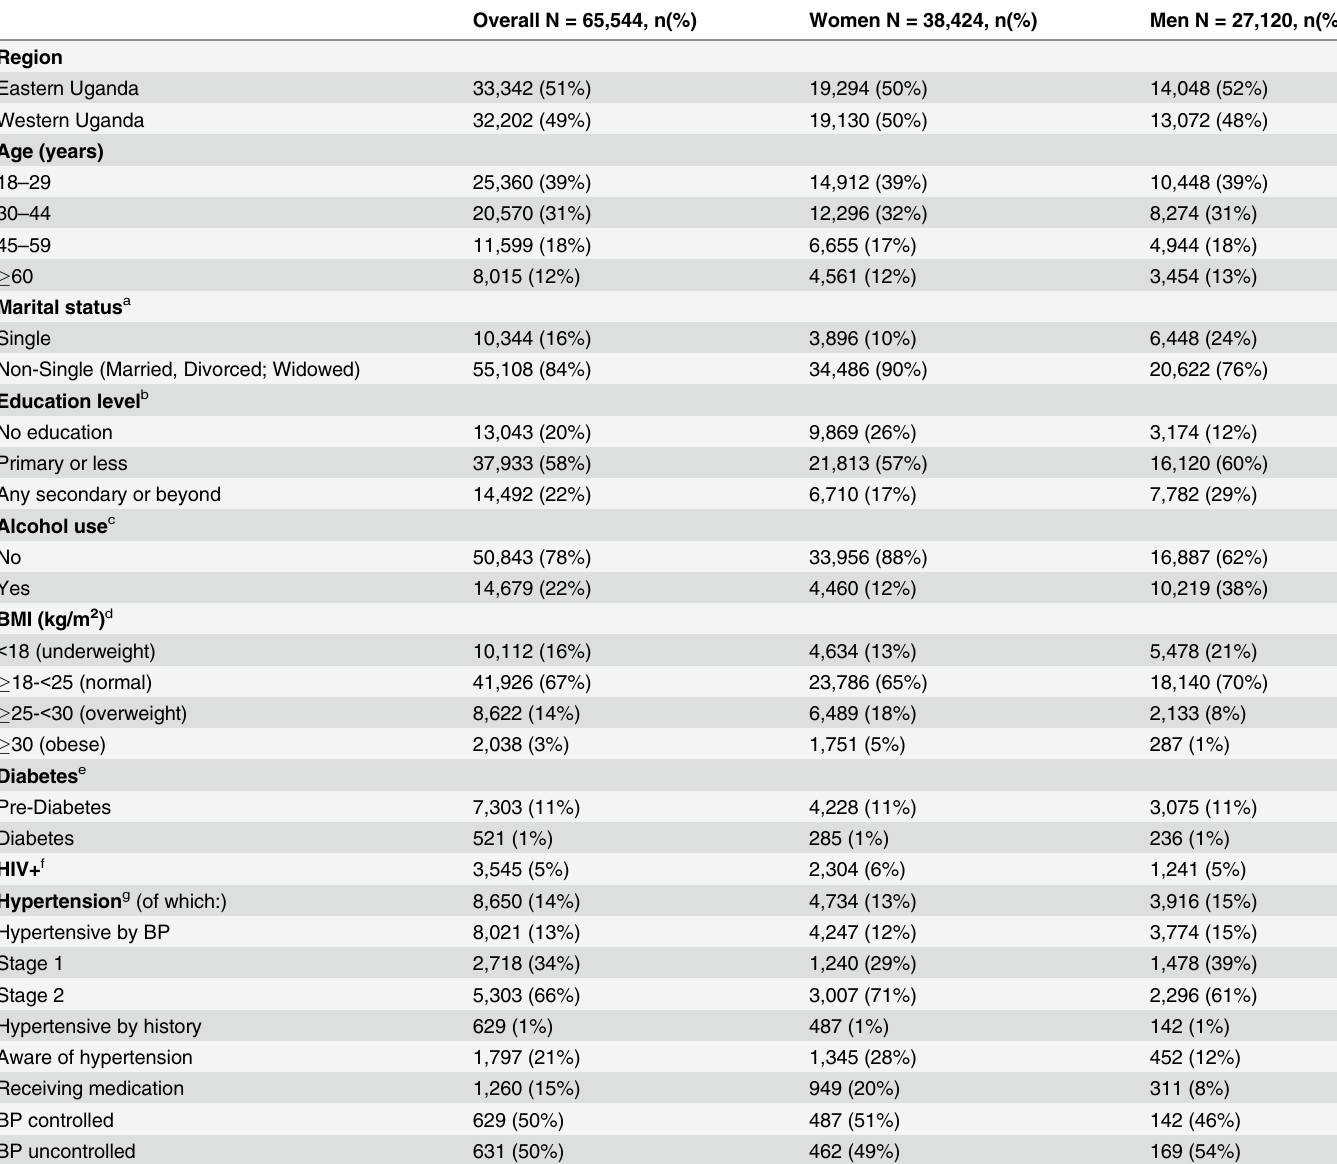
Table 1. Participant Demographics and Hypertension Prevalence, Treatment and